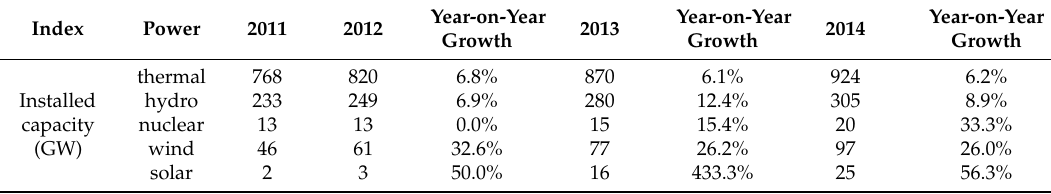
Table 1. Different installed capacity and its year ‐ on ‐ year growth rate.